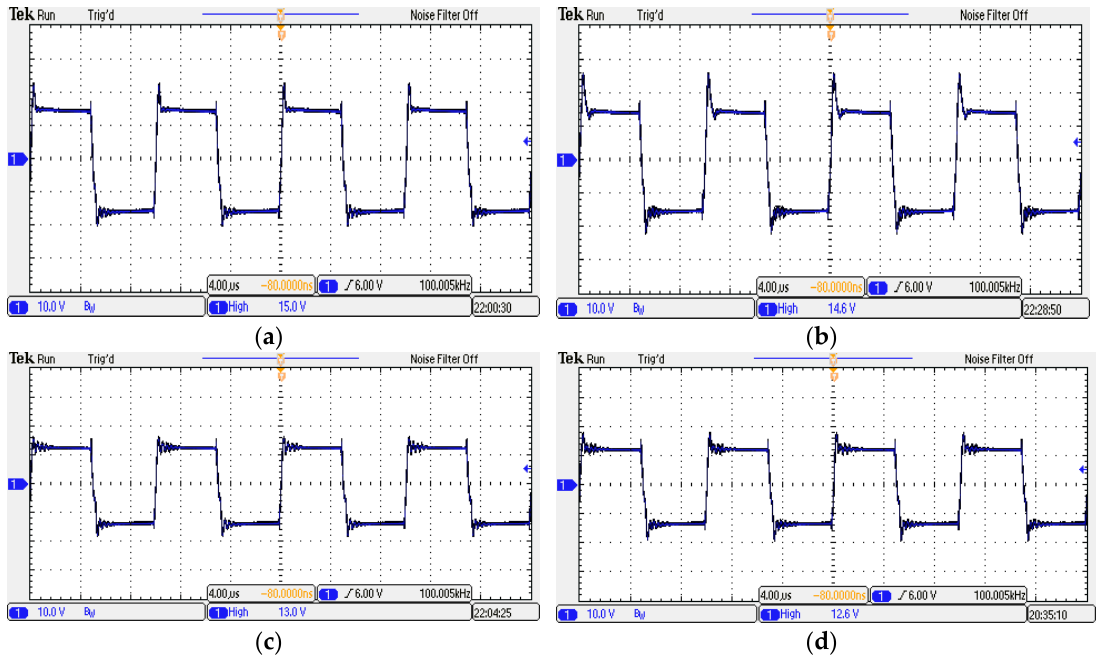
Figure 16. Driving waveforms of four typical coil layouts: ( a ) loose outer, ( b ) tight outer, ( c ) loose inner, and ( d ) tight